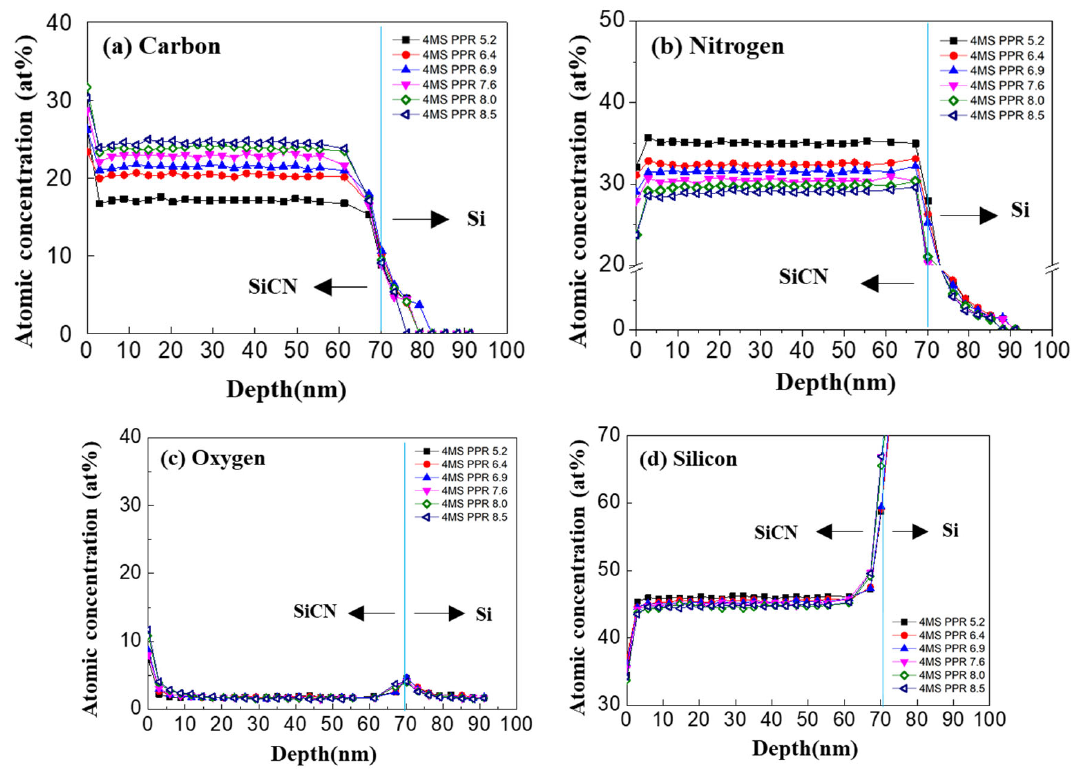
Figure 2. The distribution of components in the depth profile of the thin SiCN film through XPS analysis. ( a ) Carbon (C 1s), ( b ) nitrogen (N 1s), ( c ) oxygen (O 1s), and ( d ) silicon (Si 2p).